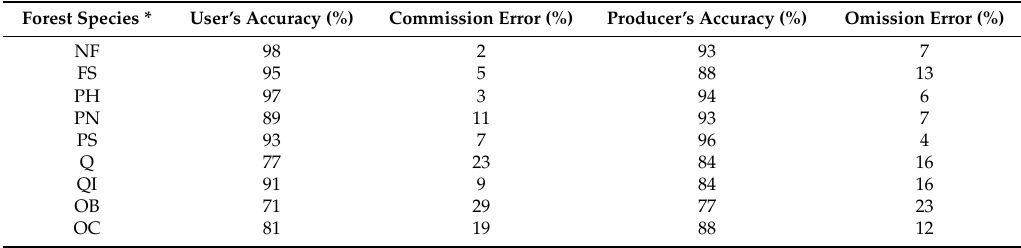
Table 2. Out-of-bag confusion matrix estimated from the random forest (RF) classification model fitted to construct a forest species map for the study